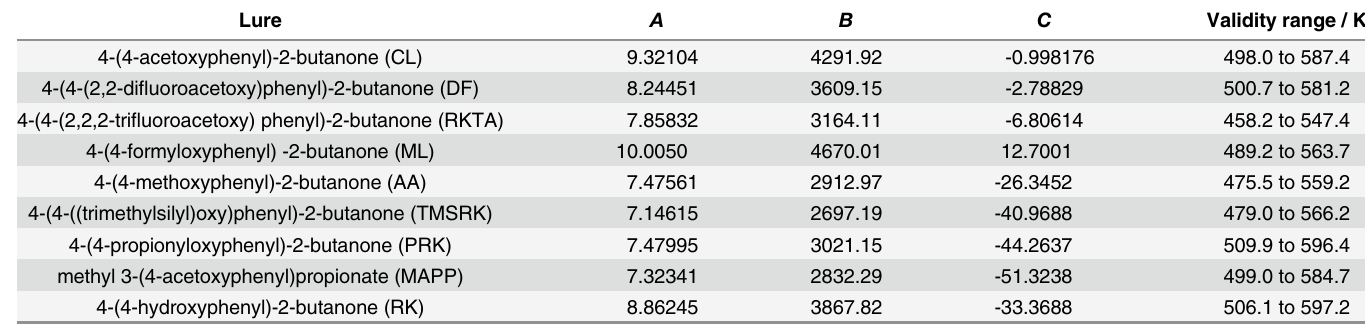
Table 2. Antoine Equation Parameters Determined by Non-Linear Regression Analysis of the Vapour Pressure Data and Their Validity Range. Lure A B C Validity range / K